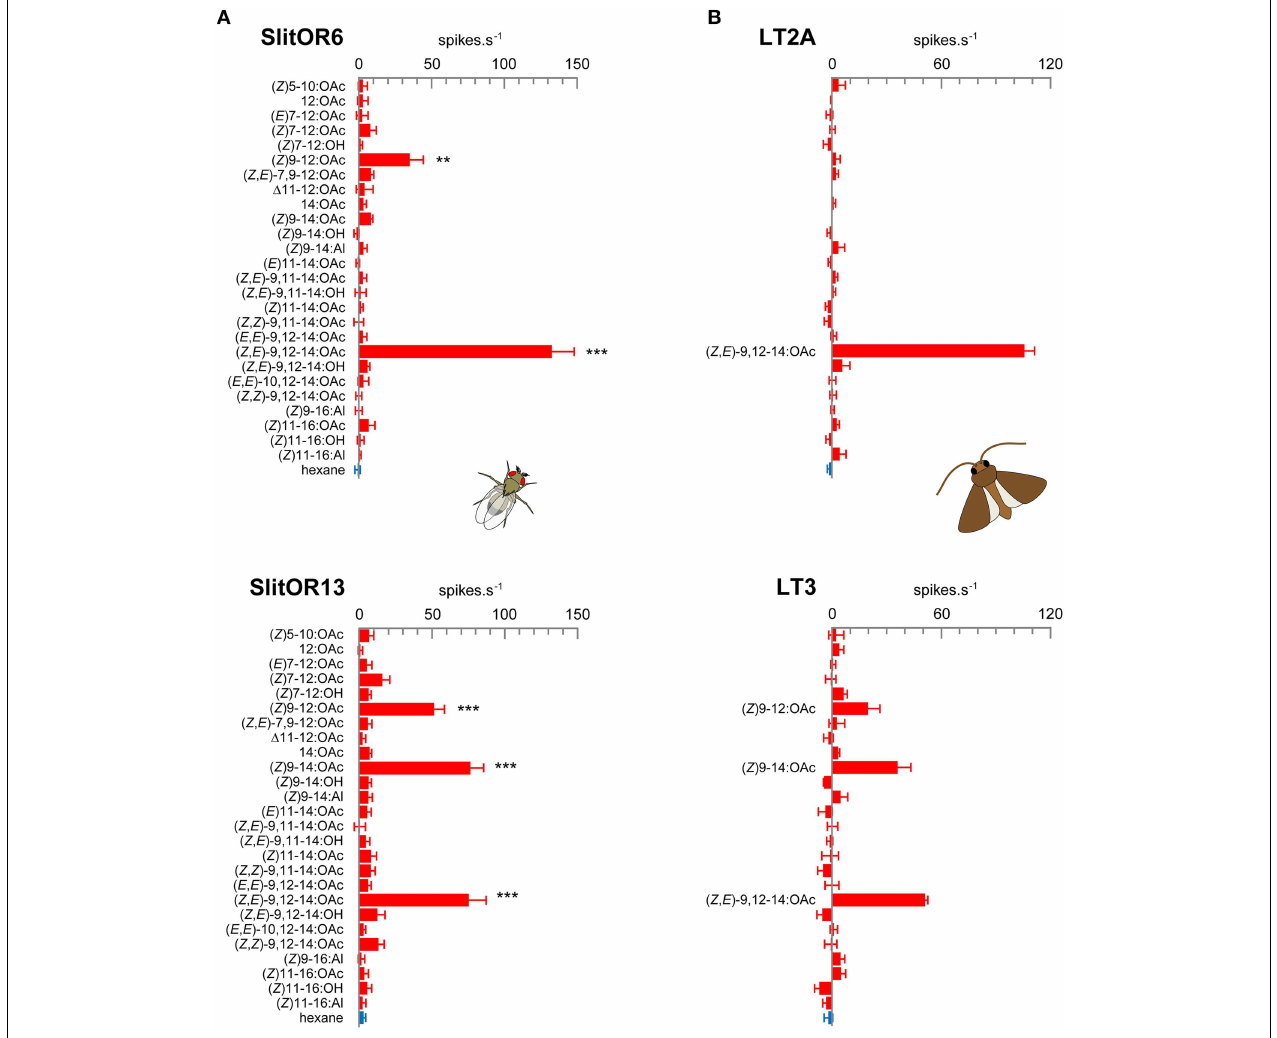
(10 µ g in the stimulus cartridge for single-sensillum recordings on Drosophila , 1 µ g for recordings on Spodoptera ). Error bars indicate SEM ( n = 5 –9 for SlitOR6, n = 7 –12 for SlitOR13, and n = 3 for S. littoralis OSNs). *** P < 0 . 001 , ** P < 0 . 01 significantly different from the response to solvent (Mann-Whitney U